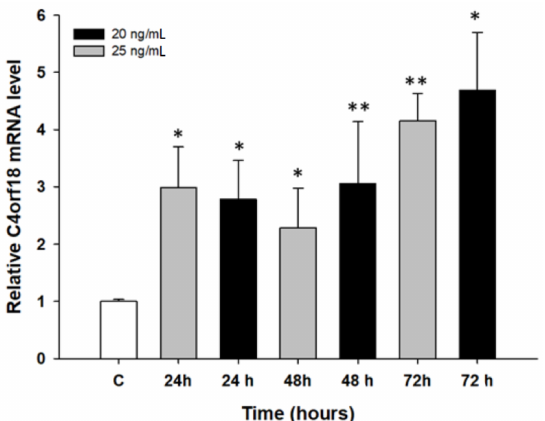
Figure 8. Expression analysis of the C4orf18 gene in the A2780 cell line. The figure presents the relative gene expression in the PAC-treated cells (grey and black bars) with respect to that of the untreated control (white bars), which was assigned a value of 1. The values were considered significant at * p < 0.05 and ** p < 0.01.